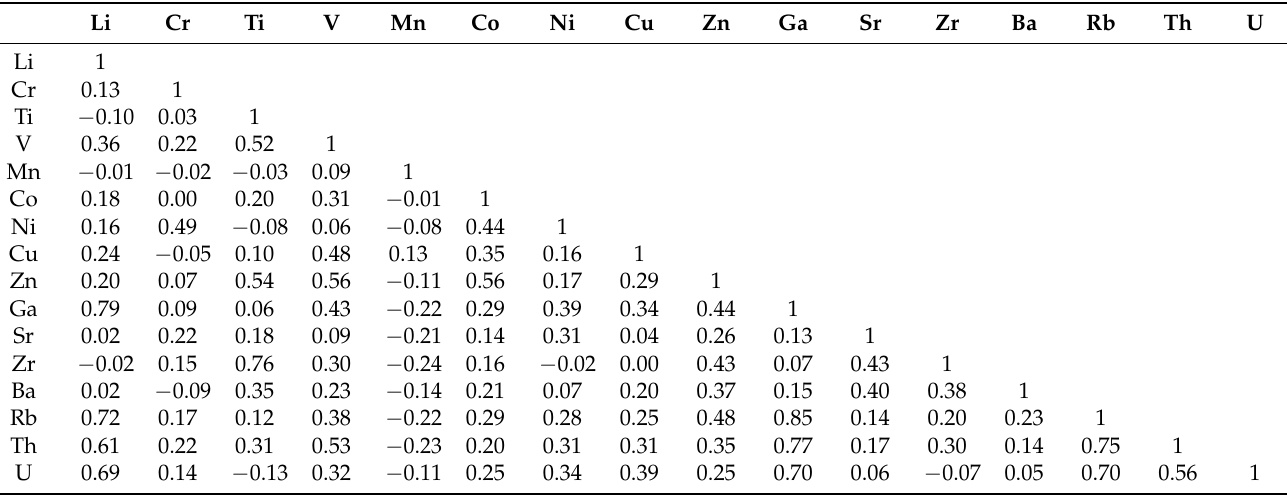
Table 3. Correlation coefficients of trace elements in the mudstones of the Guantao Formation.